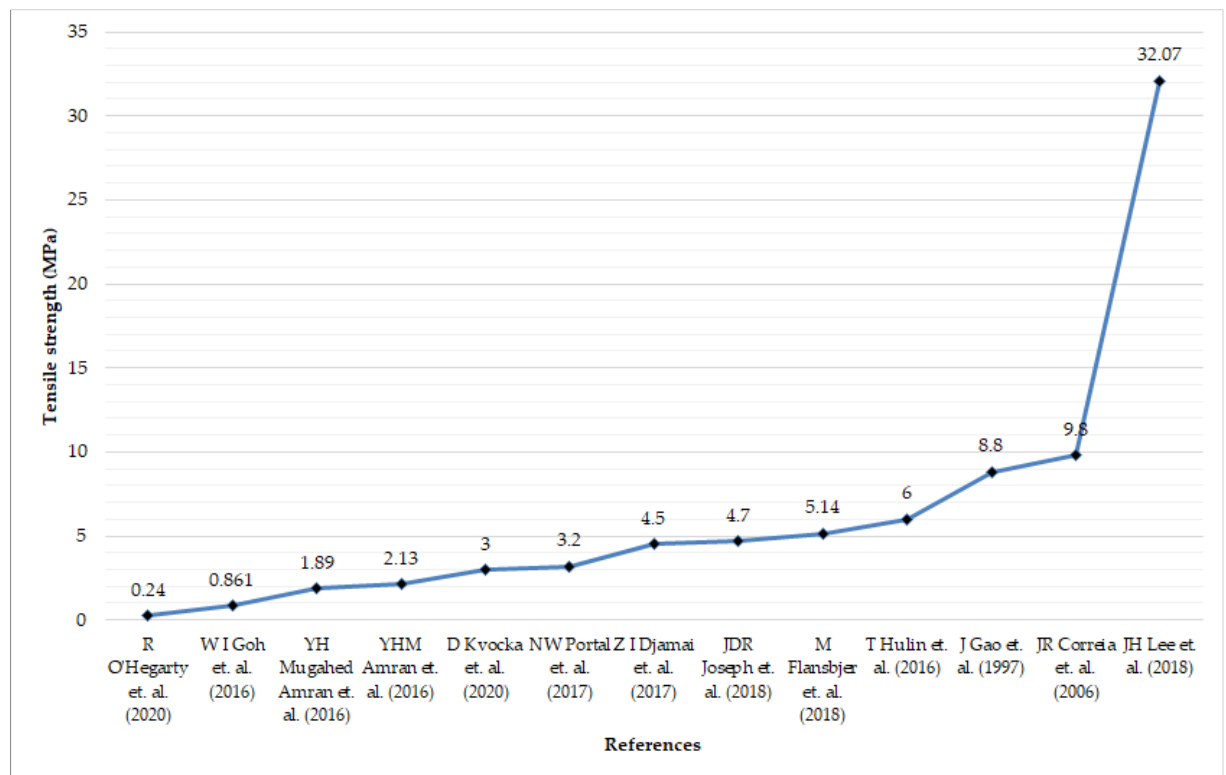
Figure 5. Tensile strength in the presented literature .